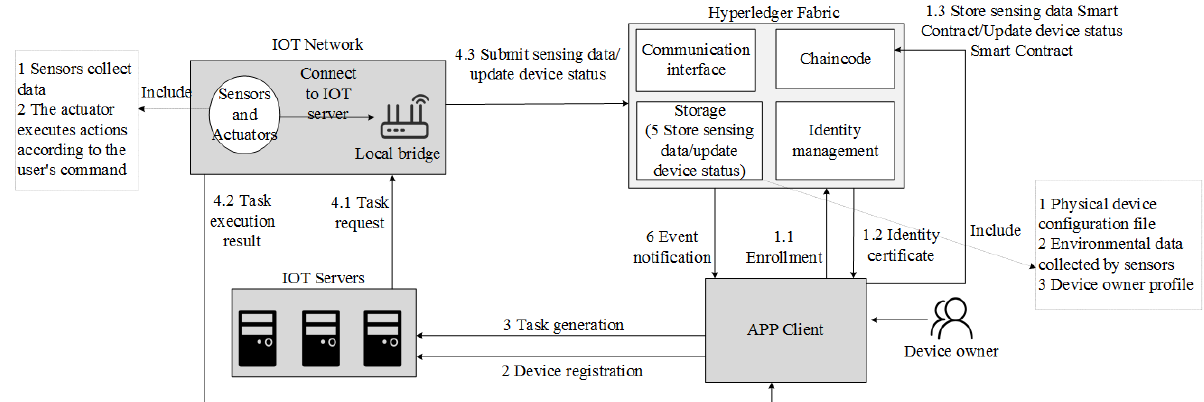
Figure 10. Reconstruction diagram of reference [31].